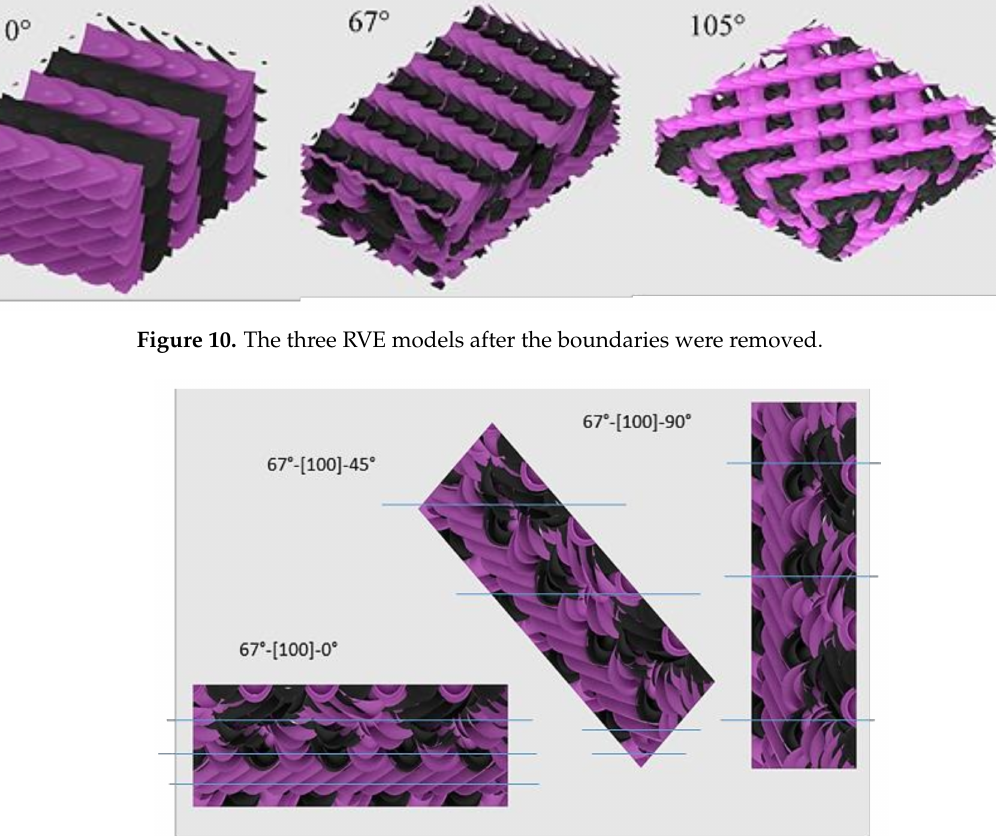
Figure 11. The 67 ◦ hatch angle model rotated around the [100] direction by 0 ◦ , 45 ◦ , and 90 ◦ , where the lines are example slices through the